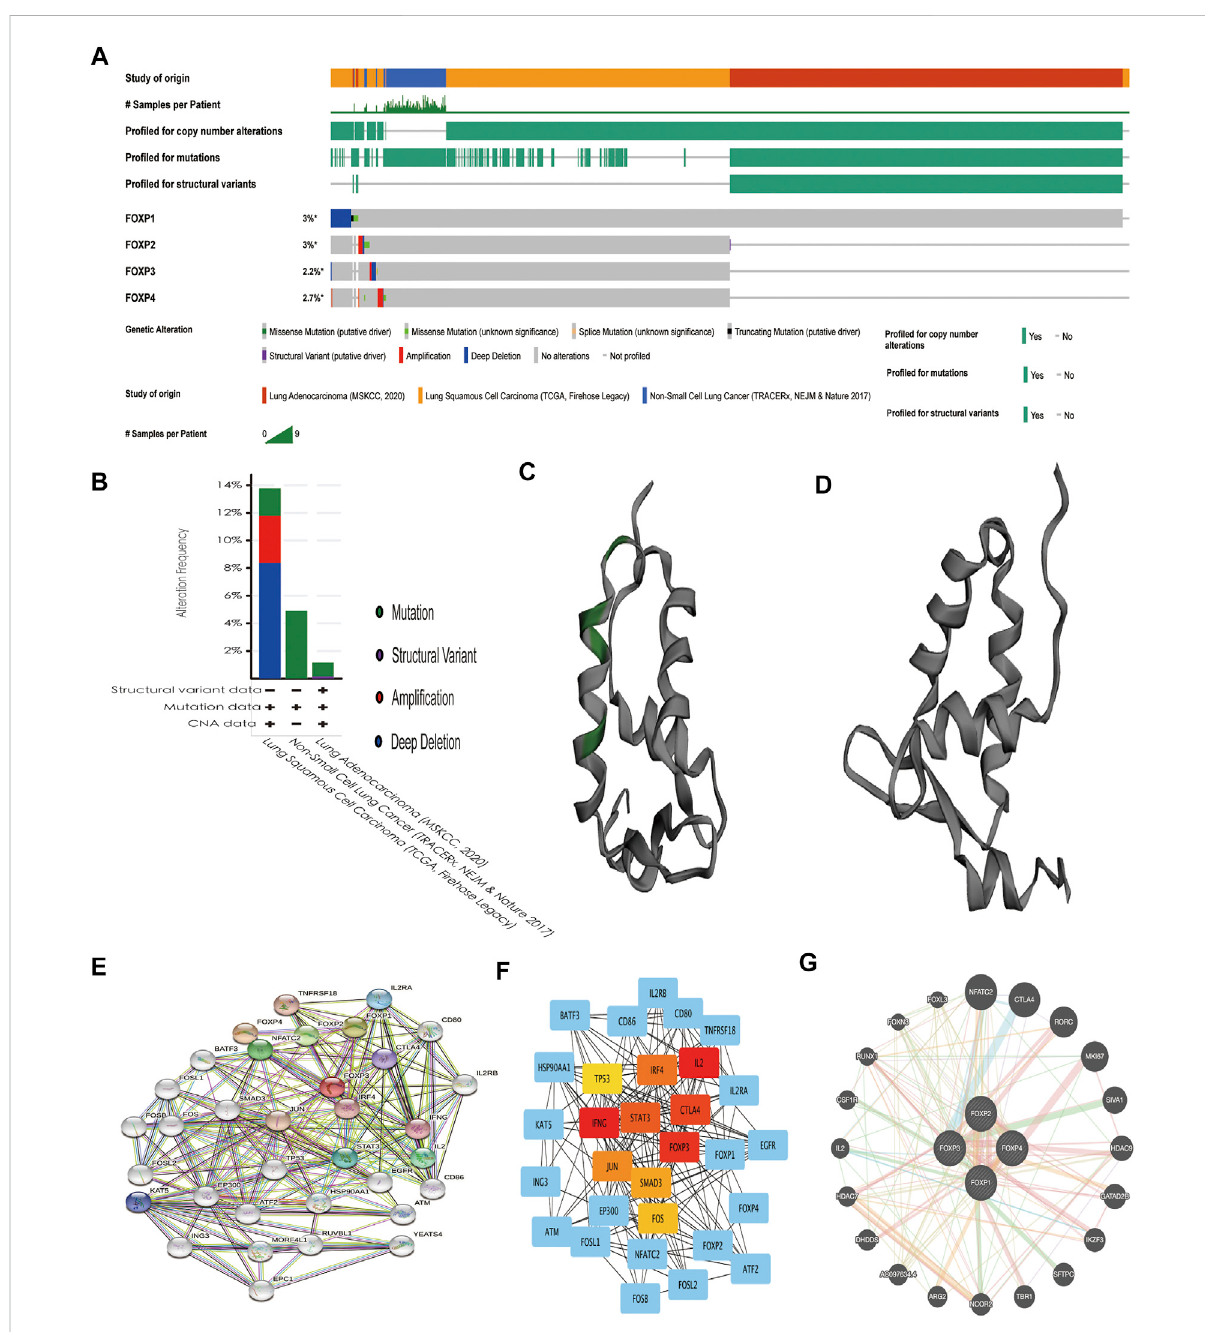
FIGURE 13 Genetic alteration, and interaction analyses oftheFOXPfamily inNSCLC patients. (A) The heatmap showed therespective frequenciesof Gene alterations occurring in the sequenced cases by the FOXP family in the data obtained from the OncoPrint schematic of cBioPortal. (B) The mutation types of NSCLC in three datasets. (C) The chromosomal structure of FOXP1 with domain mutations. (D) The chromosomal structure of FOXP2/3/ 4withoutdomainmutation. (E) Theprotein-proteininteractionPPInetworkanalysisoftheFOXPfamilyusingSTRING. (F) Thetop10hubgenes were exported by Cytoscape (version 3.7.2) with the cytoHubba app. (G) The result of GeneMANIA reveals functionally similar genes of the FOXP